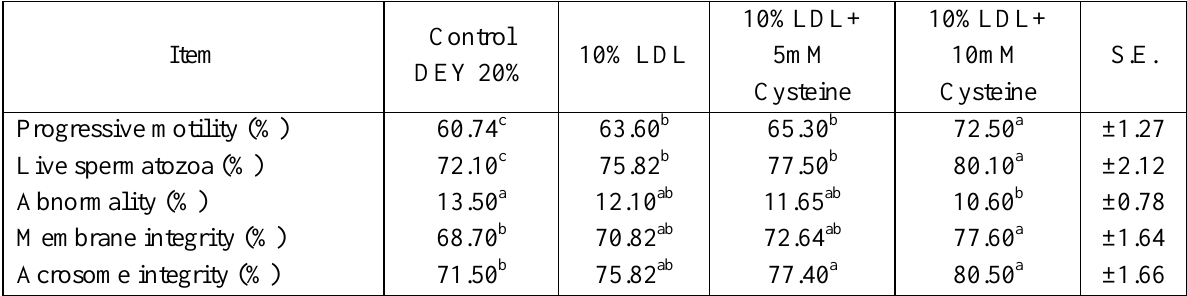
Table 4: Effects of 10% DEY-LDL and Cysteine based extender on Post-dilution parameters of Holstein bull spermatozoa